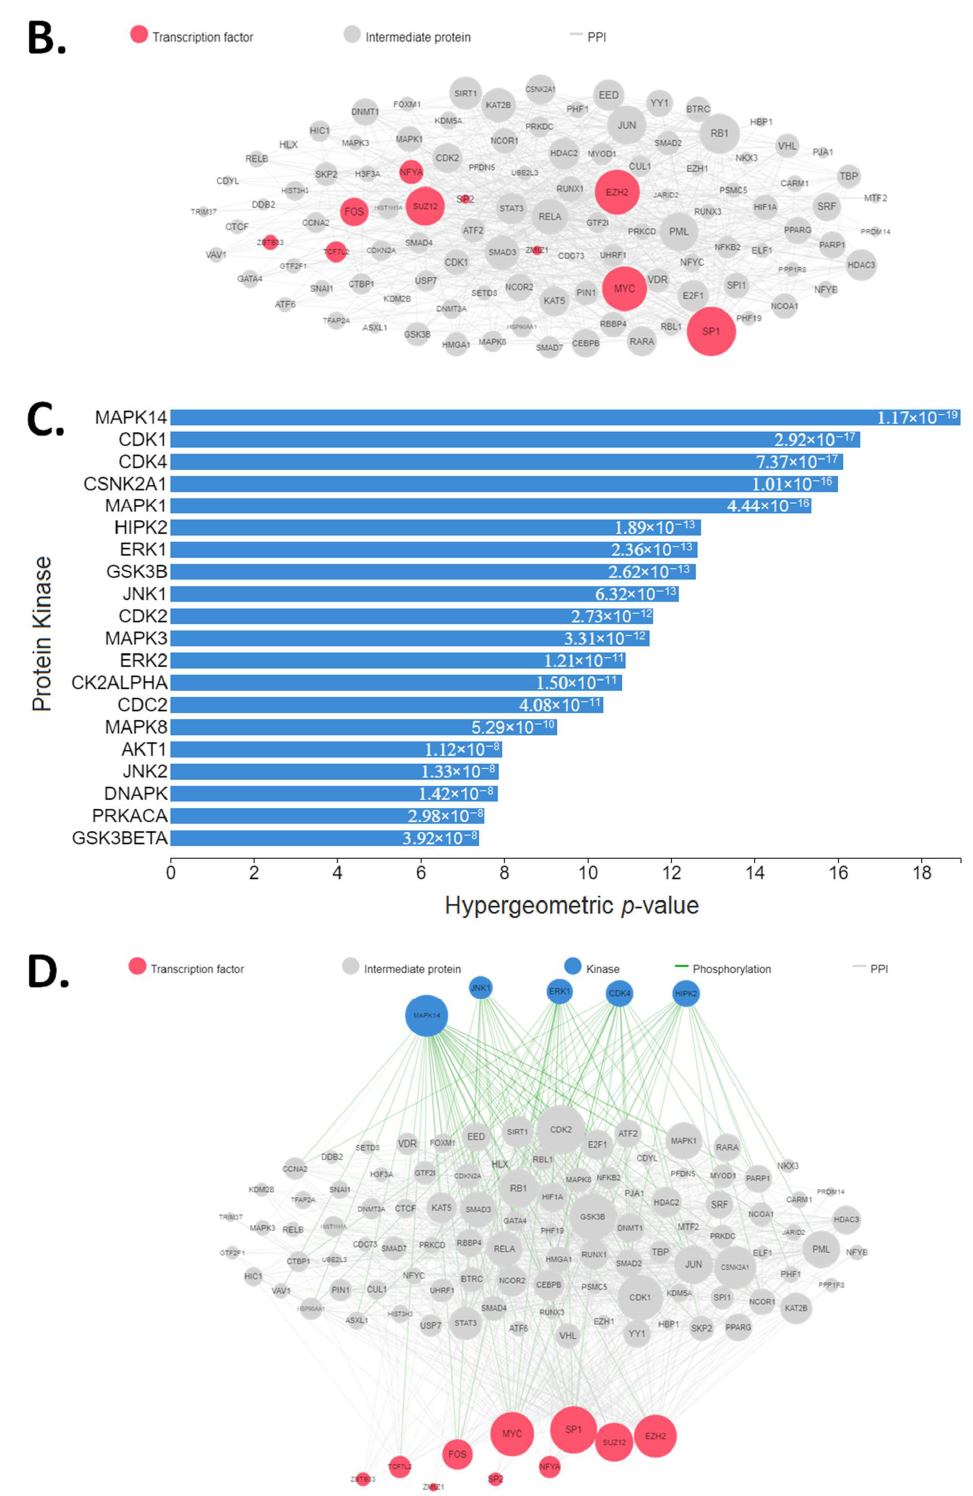
Figure 3. Upstream regulatory pathway analysis of the 35 selected differentially expressed genes: ( A ). transcription factor enrichment analysis; ( B ) protein–protein interaction expansion; ( C ) kinase enrichment analysis; ( D ) eXpression2Kinases network. Figures were obtained from the X2K Web (https://amp.pharm.mssm.edu/X2K/, accessed on 12 May 2021) after running the upstream pathway analysis of the selected genes as the input gene